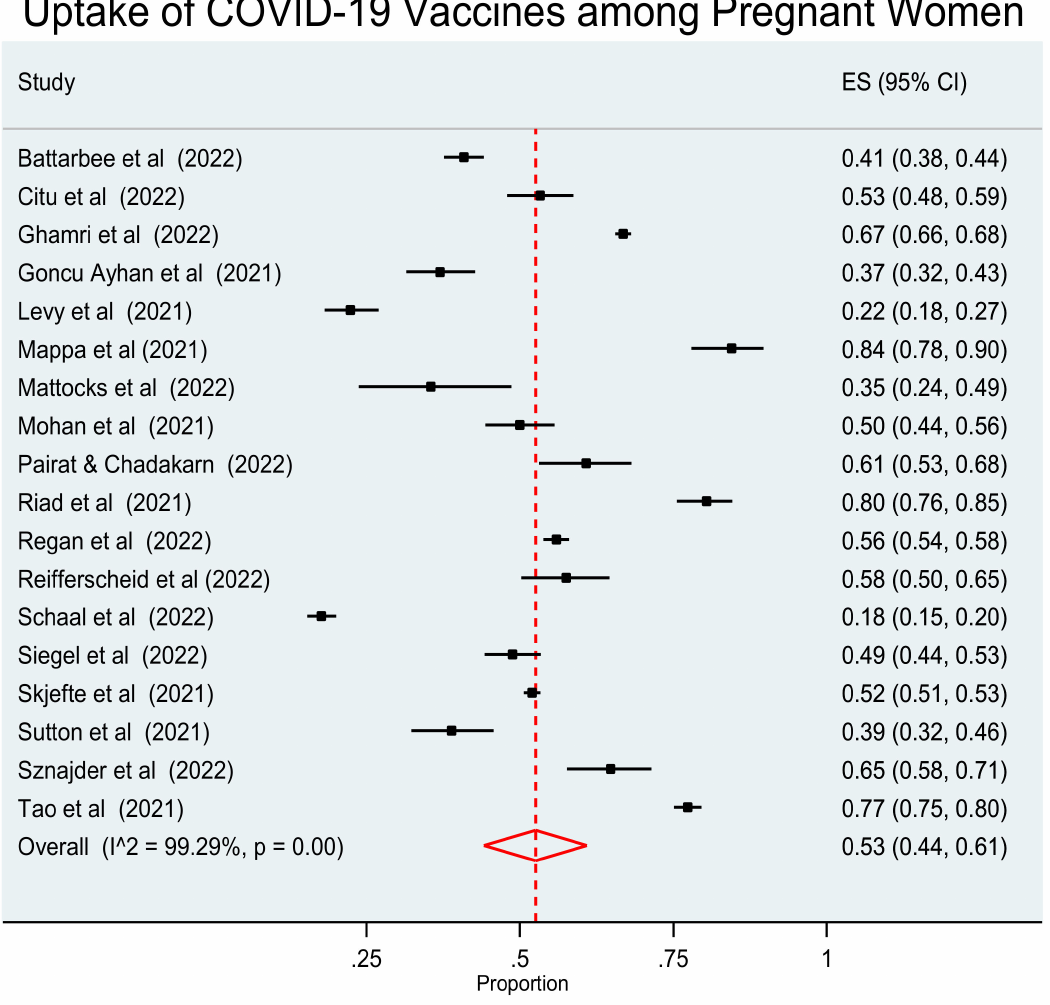
Figure 2. Forest plot of studies reporting vaccination acceptance against COVID-19 in pregnant women. Vertical ticks and horizontal lines show the mean effect and 95% confidences interval for each study. The red diamond at the bottom shows the cumulative effect with 95% confidence